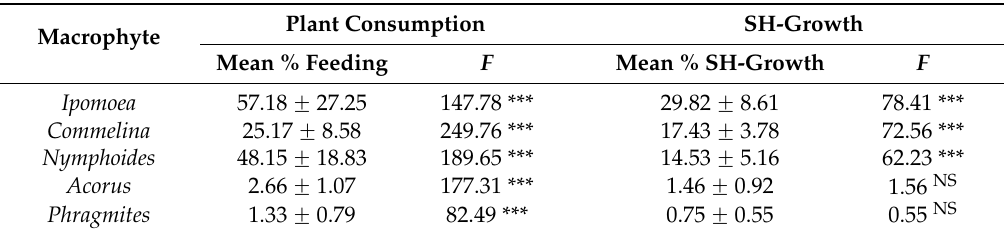
Table 2. Mean values ( ˘ SD) of percentage plant consumption and percentage SH-growth of Pomacea canaliculata fed with each of the five macrophyte species during the study